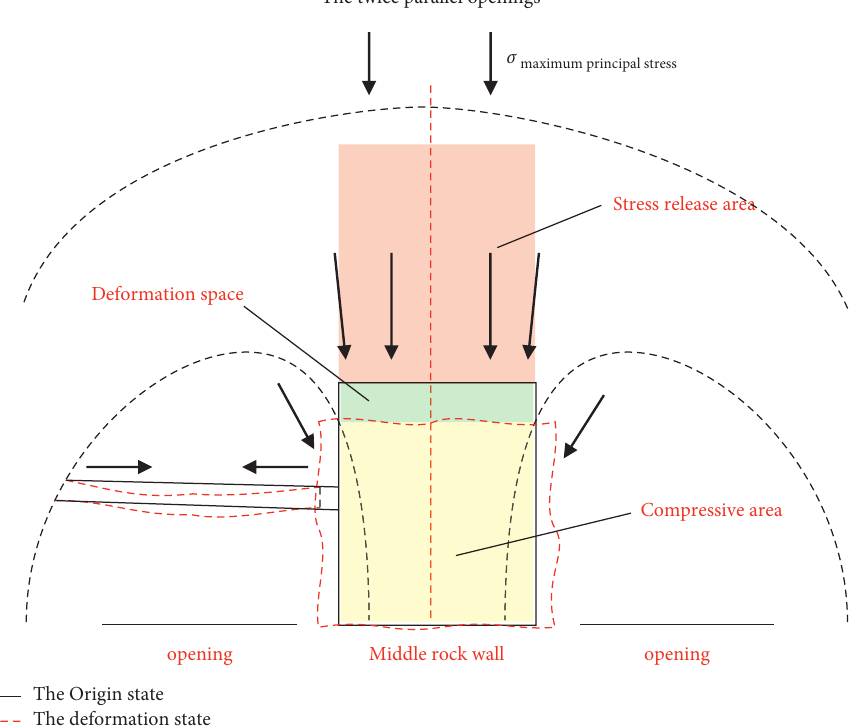
Figure 7: The illustration of the stress change in the middle rock wall.